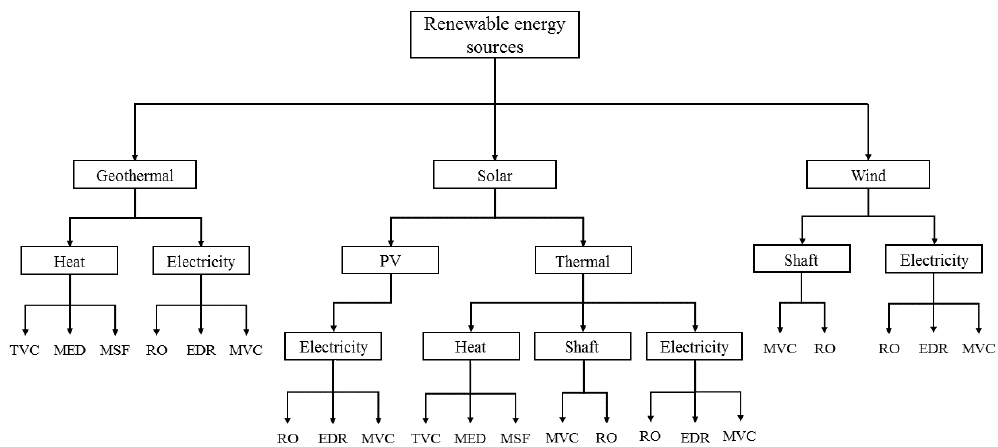
Figure 1. Combinations technologies of RES (Renewable Energy Sources) and desalination methods, adapted from Etawil [10], with permission license number 4000740930381 from Renew. Sustain. Energy Rev (Elsevier). 2009.